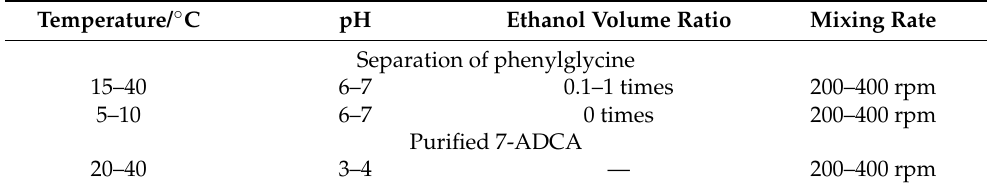
Table 15. Process parameters for separation of phenylglycine and purification of